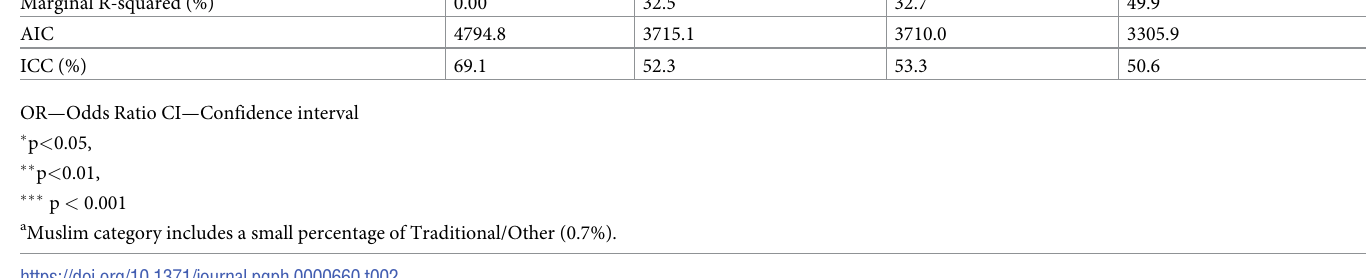
Table 3). As observed, daughters of women who believe FGM/C should discontinue have the lowest chances of being circumcised irrespective of mother’s education, compared to the other attitude categories. For this group, it can be observed that the probability decreased further by an estimated 40% if the woman has had higher education (3.0%) compared to having no edu- cation (5.0%). Among women who believe FGM/C should continue, the probability of their (64%) compared to those with no formal education (49%). Given this result, we decided to fur- ther investigate the characteristics of mothers who believe FGM/C should continue. In our of those who have secondary and higher education had been circumcised (Table B in S1 Text).